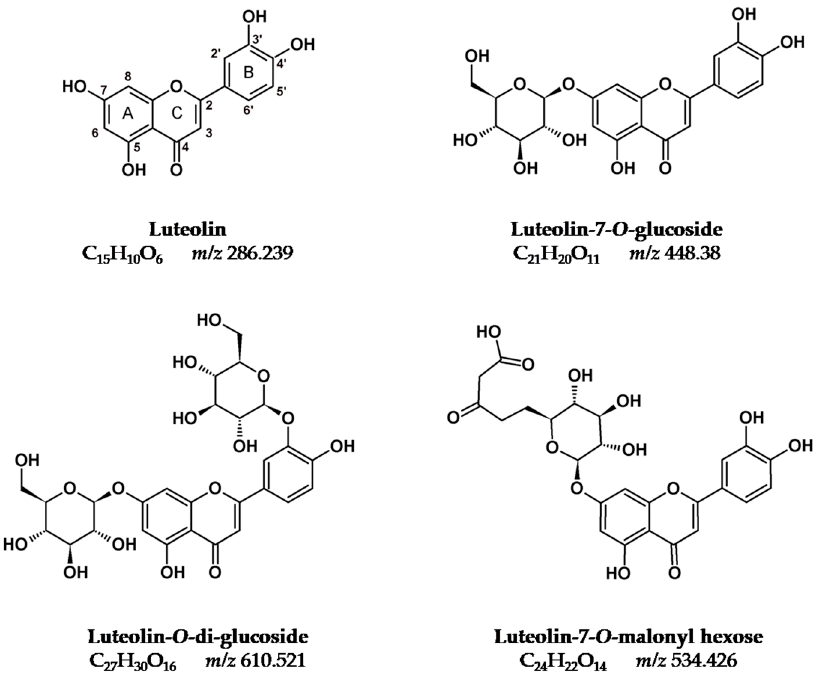
Figure 1. Luteolin-based chromophores (flavones)